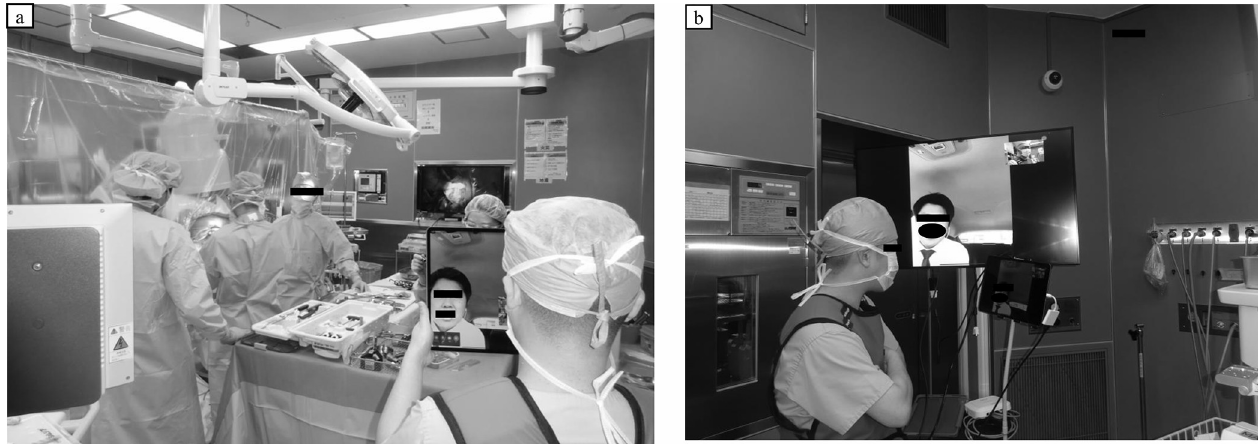
Fig 1. A vendor attending a surgery online. Images of a vendor attending a surgery online.